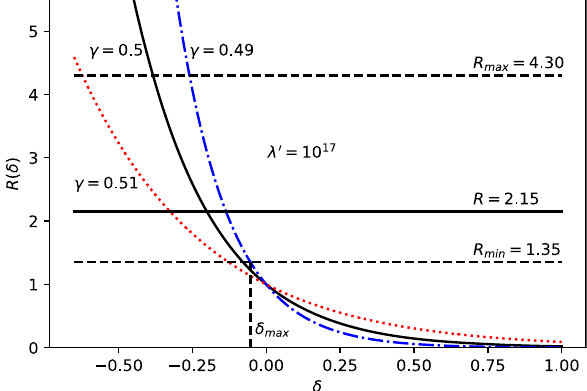
Fig. 8 R vs δ for fixed λ (cid:9) = 10 17 and energy E = E 12 (cid:2) 5 . 9 × 10 − 6 eV. The dash-dot blue, solid black and dotted red lines represent γ = 0 . 49 , 0 . 50 , 0 , 51